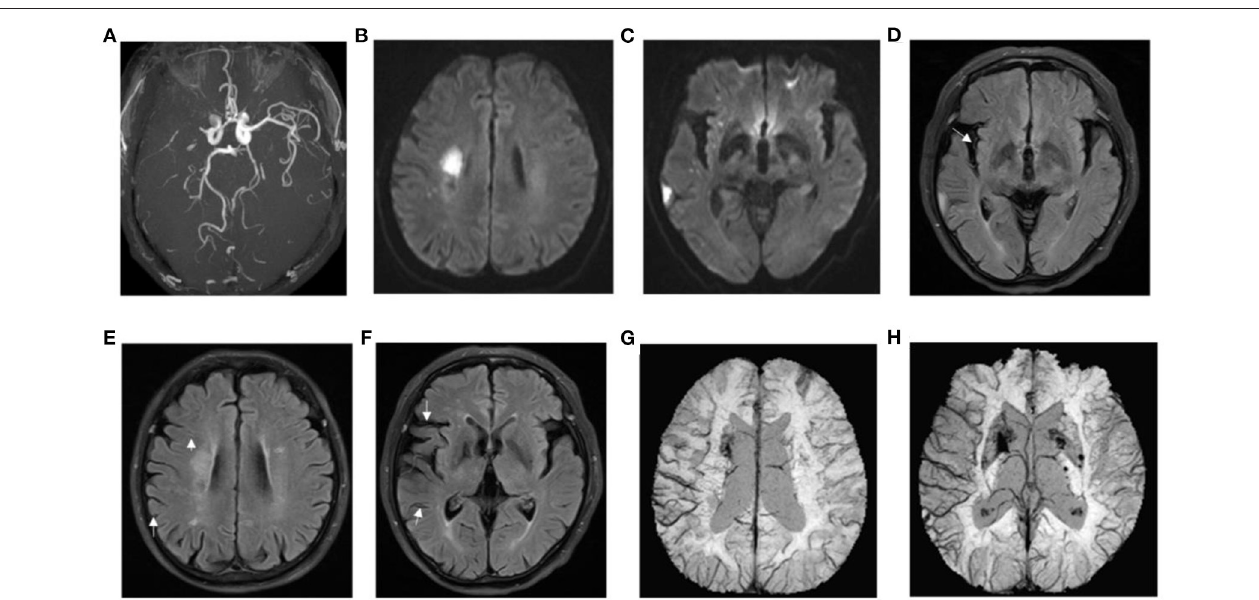
FIGURE 5 | Presentation of a typical patient. A 62-year-old man with left limb weakness for 5h. (A) right prominent laterality posterior (PLPCA) and anterior (PLACA) cerebral arteries; (B,C) diffusion-weighted imaging indicated acute cerebral infarction, and the DWI-ASPECTS was 7; (D–F) T2 fluid-attenuated inversion recovery (FLAIR) images showed hyperintense vessel sign (HVS), and a HVS score of 3; (G,H) susceptibility weighted imaging demonstrated prominent hypointensity vessel sign (PVS), and SWI-ASPECTS was 3. DWI-SWI mismatch score was 4. The patient had a favorable prognosis with a mRS of 1 at 90 days.